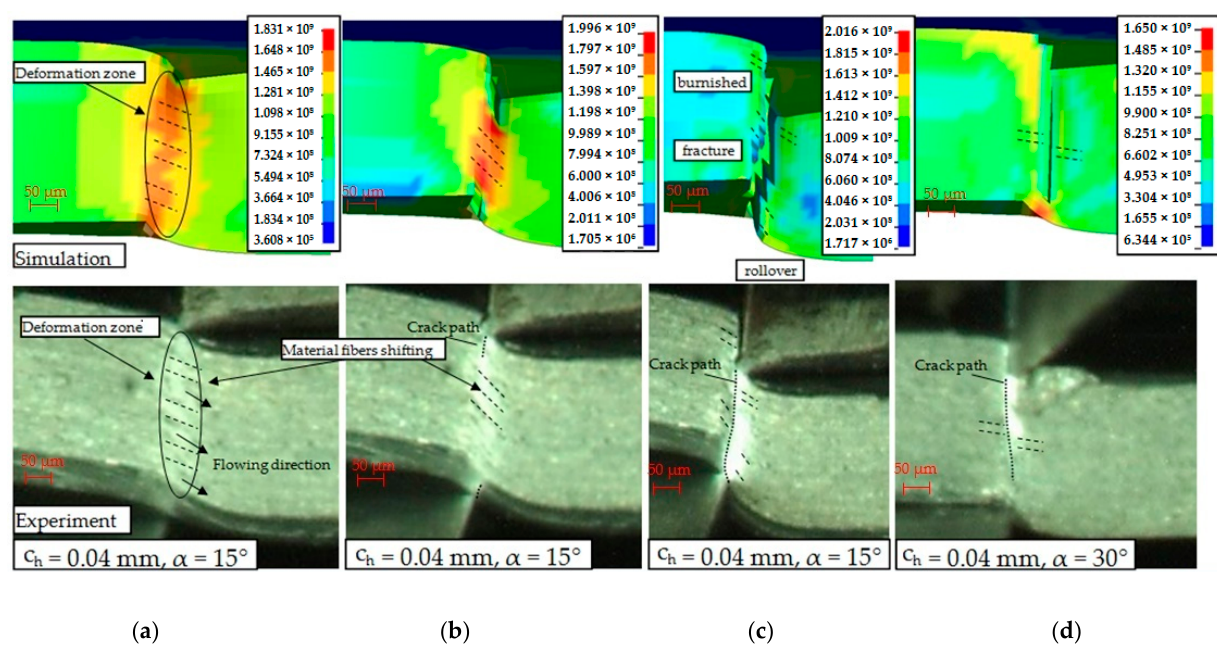
Figure 6. Formation of slit edges at sheet cross section: ( a ) plastic flow phase; ( b ) cracking phase; ( c ) final separation; ( d ) cracking phase with different tool geometry.